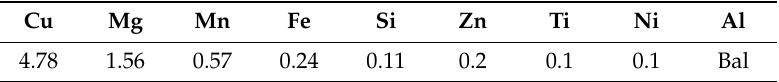
Table 1. Chemical composition of the aluminum alloy (AA) 2024 sheet (wt.%). Cu Mg